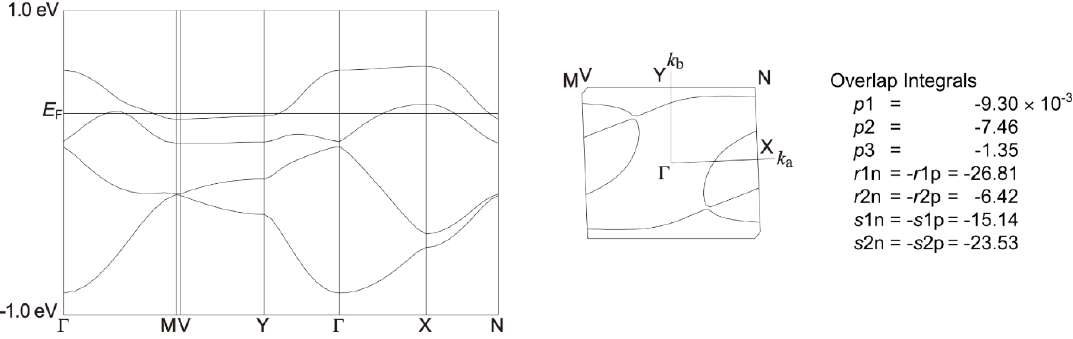
Figure 6. Band dispersions ( left ), Fermi surfaces ( centre ) and overlap integrals ( right ) of 3 . The donor···donor interactions ( p 1, p 2, etc.) are labelled in Figure 3c.